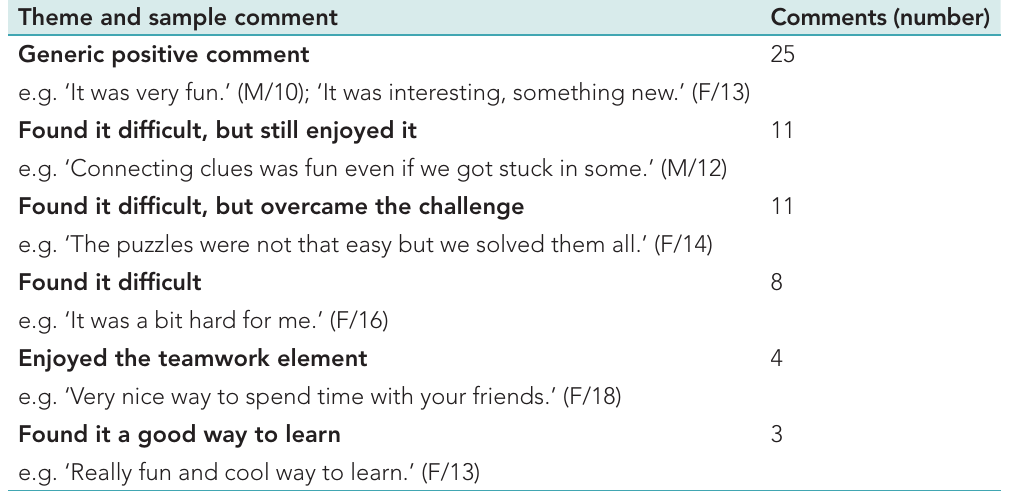
Table 4: Responses to the question, ‘What was your experience of solving the puzzles?’; gender and age of commenter is provided next to each sample comment (gender/age),